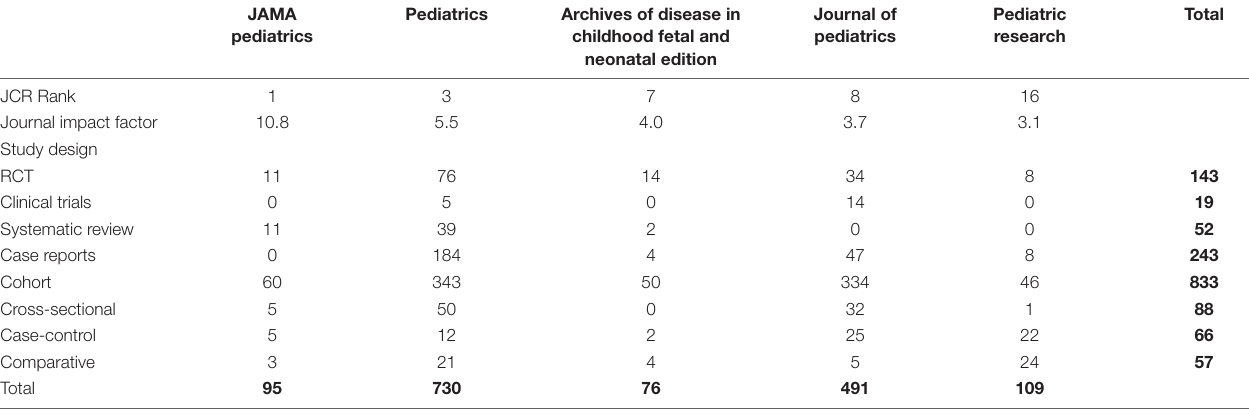
TABLE 1 | Productivity of the top 5 pediatrics journals in the specialty of neurology, including distribution by journal and by study design.